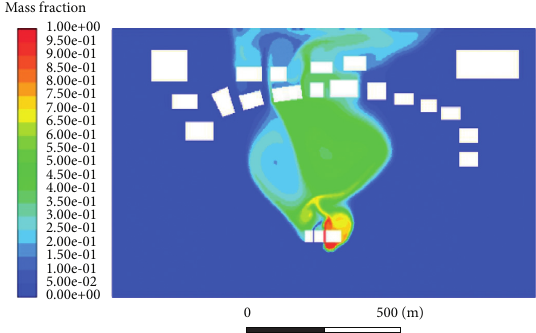
Figure 10: Radionuclide distribution rotating 270 ° clockwise at the northern break.